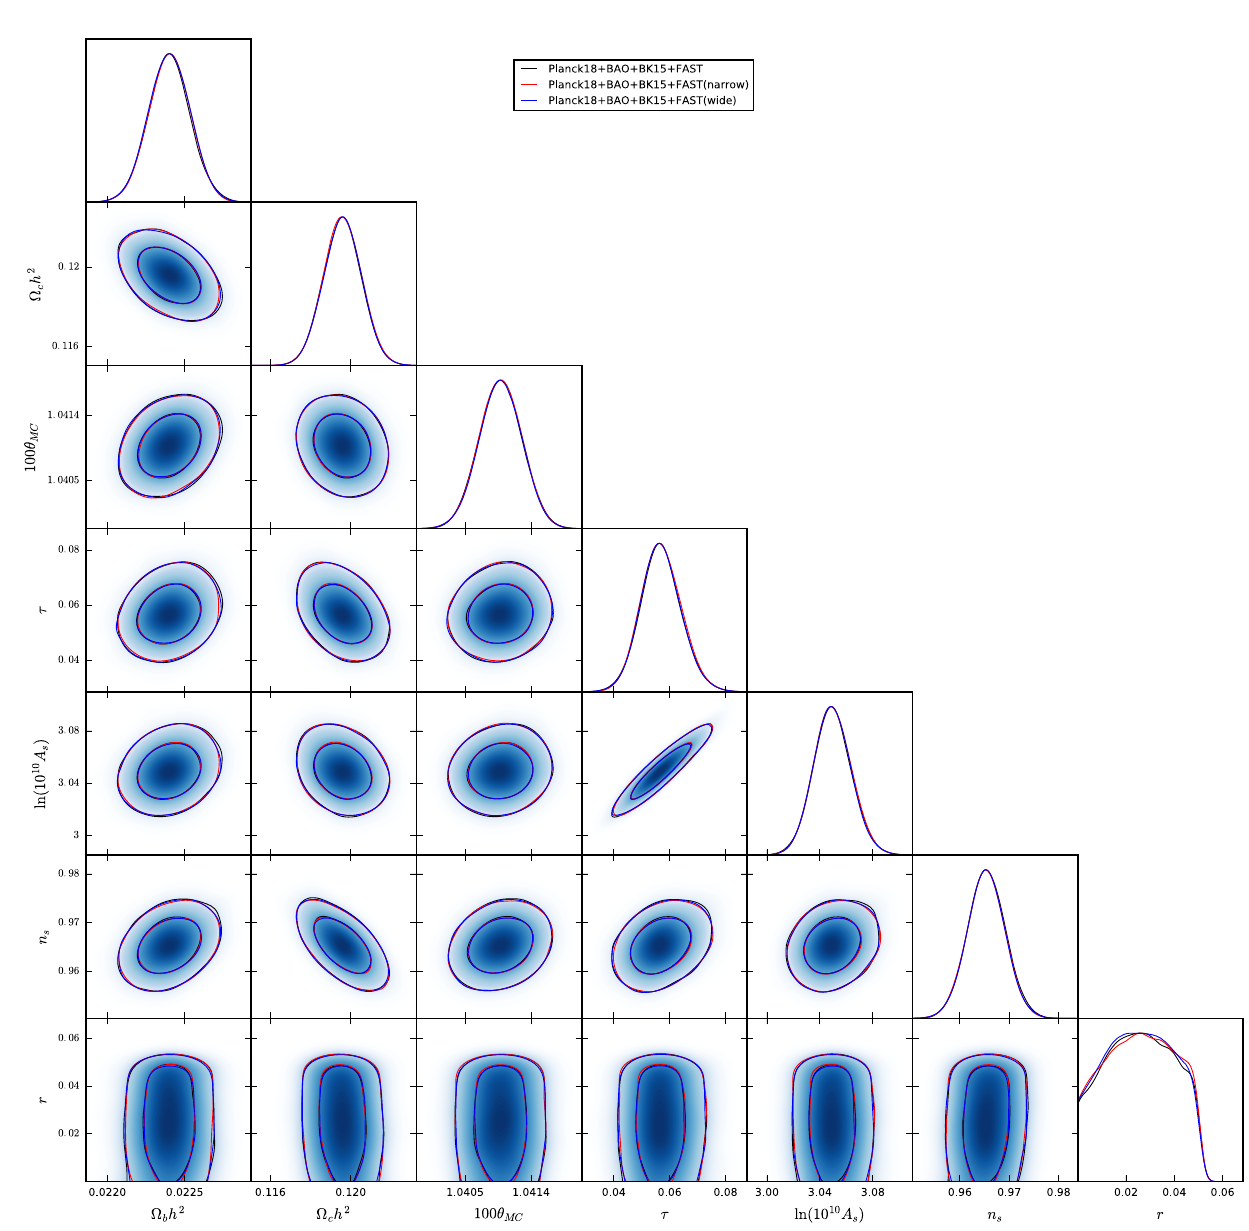
Fig. 4 The contour plots and the likelihood distributions for the cosmological parameters in the (cid:2) CDM+ r model at the 68% and 95% CL from the combinations of Planck18+BAO+BK15+FAST, Planck18+BAO+BK15+FAST n , Planck18+BAO+BK15+FAST w ,